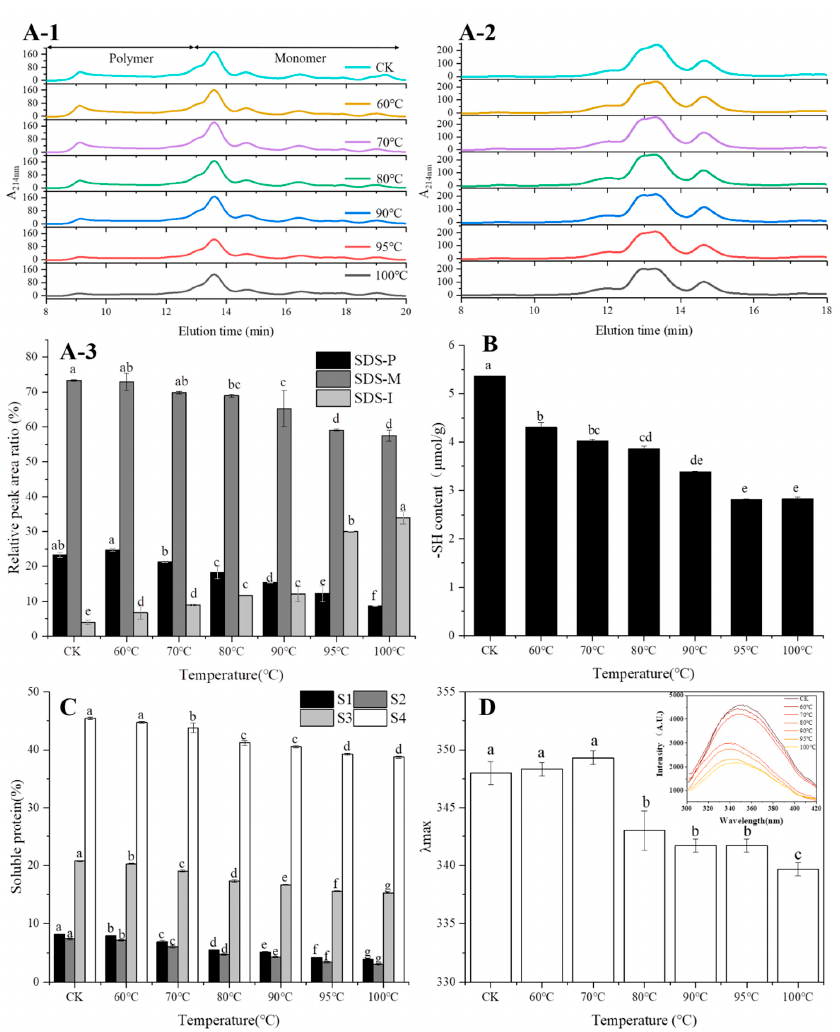
Figure 2. Typical non-reduced ( A-1 ) and reduced ( A-2 ) SEC-HPLC profiles, and relative amounts of SDS-soluble polymers, monomers and insoluble proteins ( A-3 ) with different temperature treatment. Changes of free SH ( B ) and noncovalent bonds ( C ) content with different temperature treatment. Changes in intrinsic fluorescence spectra and λ max ( D ) of protein with different temperature treatment. The different letters indicate significant difference at 0.05 level. Intermolecular interactions involved in protein polymerization during heating are mainly free SH, disulfide and noncovalent bonds. As show in Figure 2B, the free SH con- tent continuously decreased from 5.36 μ mol/g to 2.83 μ mol/g as the temperature increased from room temperature to 100 °C, with 19.86% reduction from room temperature to 60 °C.